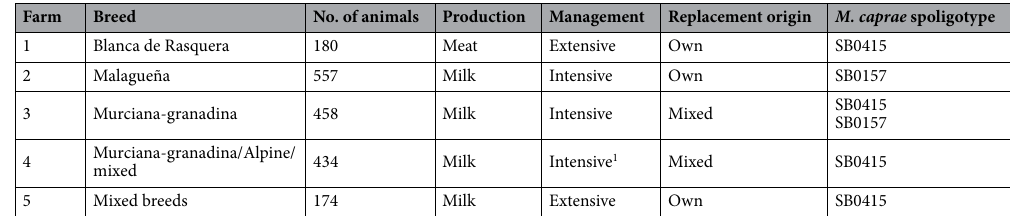
Table 5. Characteristics of goat farms. 1 Ecological farm (daily grazing for 8 h, no use of